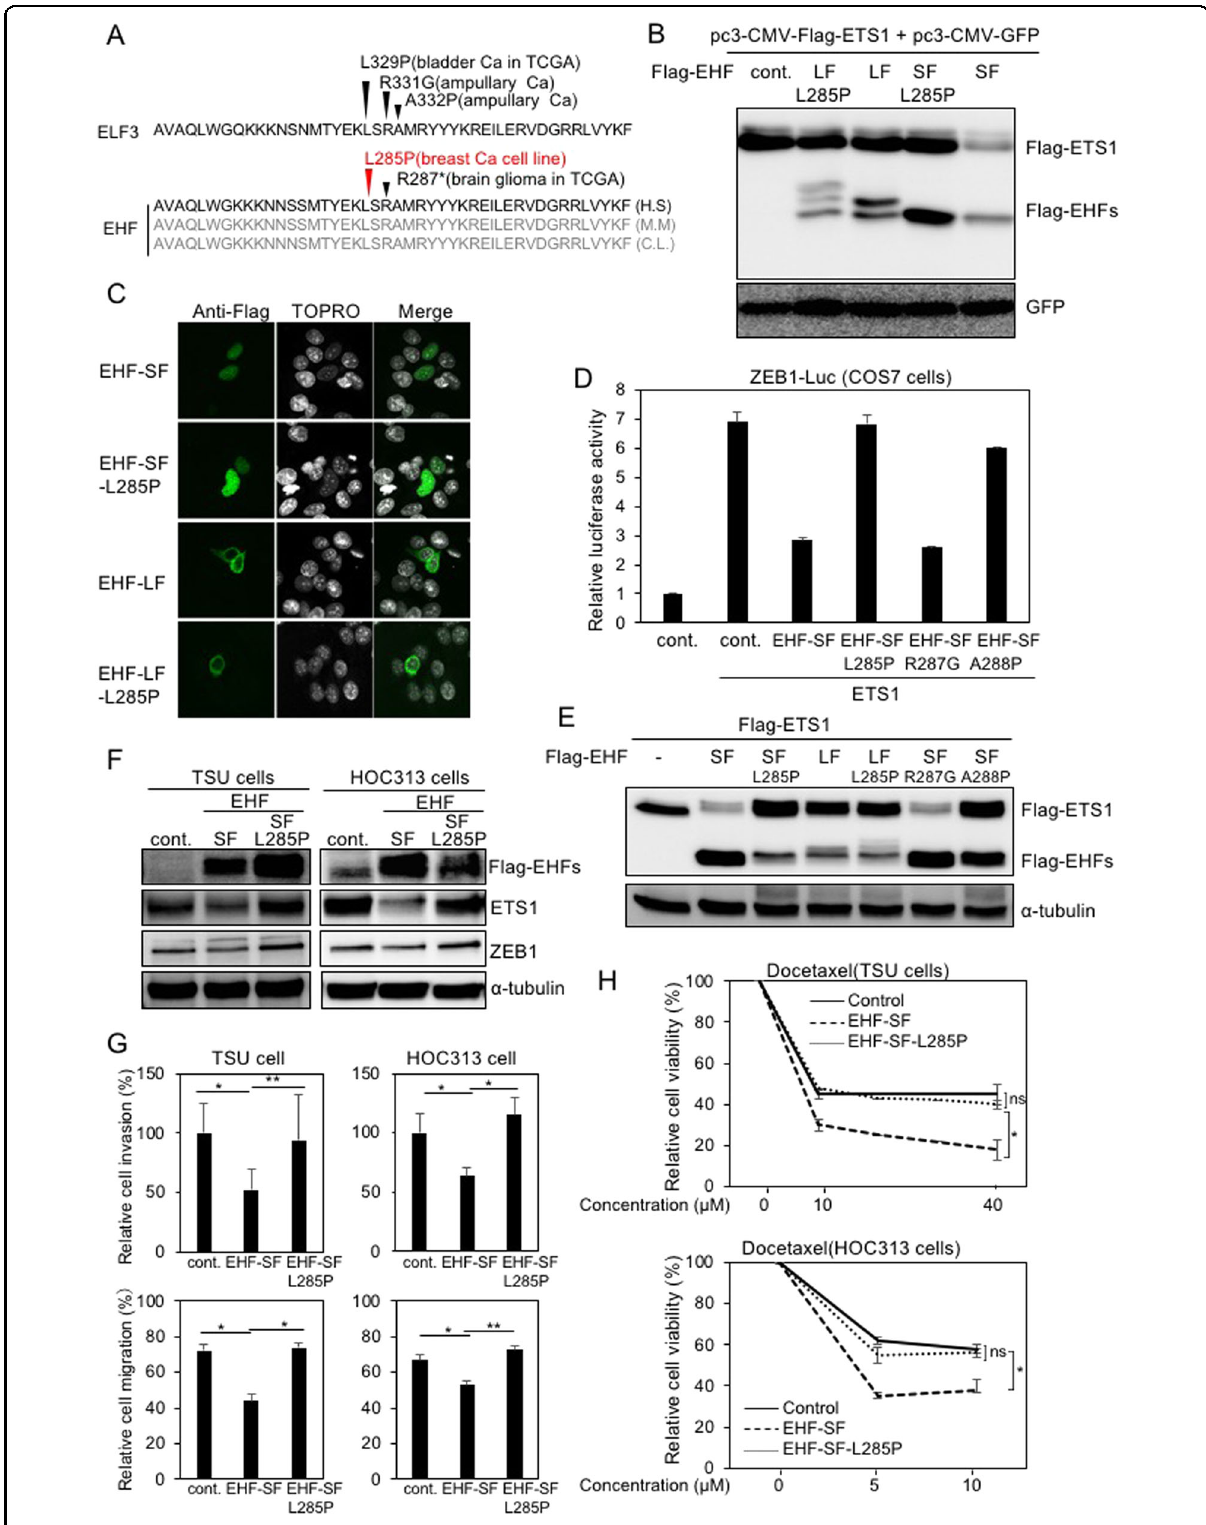
Fig. 6 (See legend on next